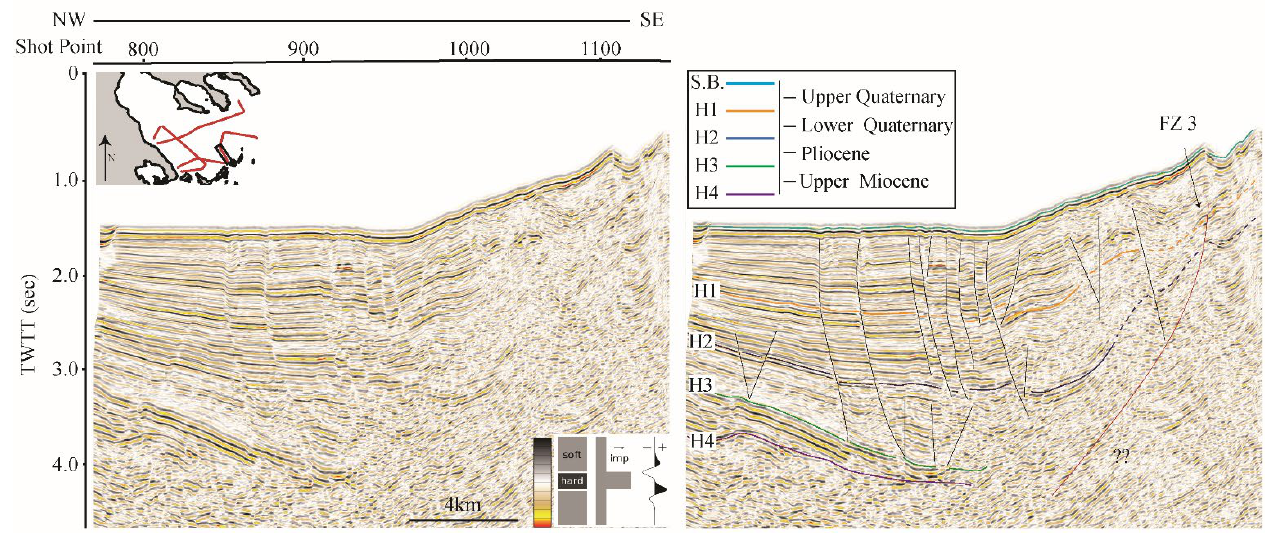
Figure 11. Seismic Line CD. Left part: un-interpreted set of regional seismic profiles. Right part: interpreted seismic section with highlighted key horizons and the most prominent tectonic elements.